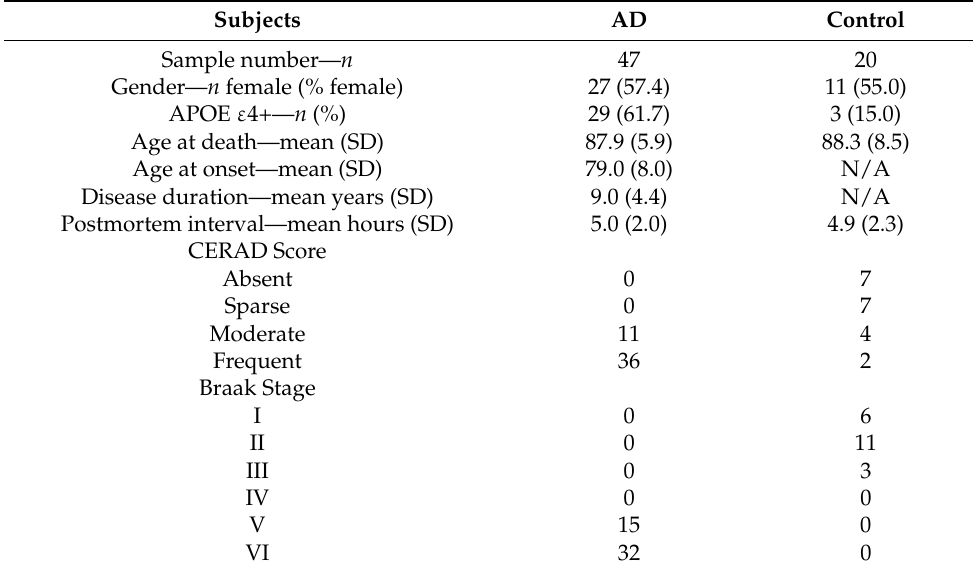
Table 1. Demographics of the PMB study